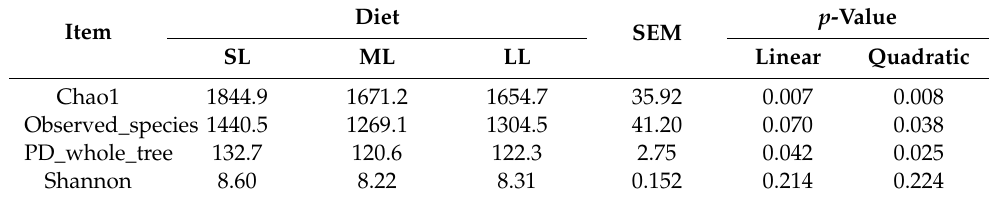
Table 5. E ff ects of roughage length on the rumen bacteria alpha diversity of weaned